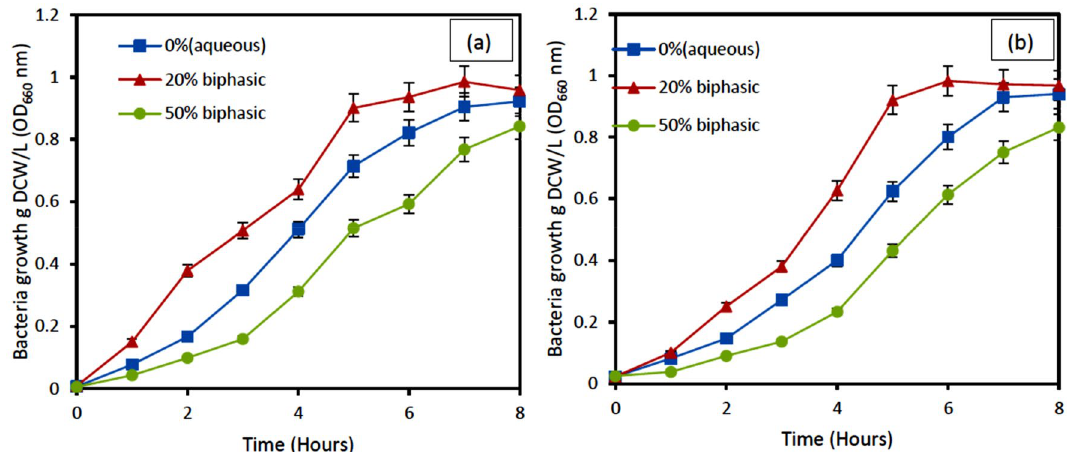
Figure 7. Effect of biphasic (oil–water ratio) on the growth of ( a ) Pseudomonas aeruginosa ( b ) Pseudomonas Putida. Experimental conditions: Initial DBT concentration of 500 ppm, Temperature 37 °C ( Pseudomonas aeruginosa ) 30 °C ( Pseudomonas putida ), Shaking speed 130 rpm.